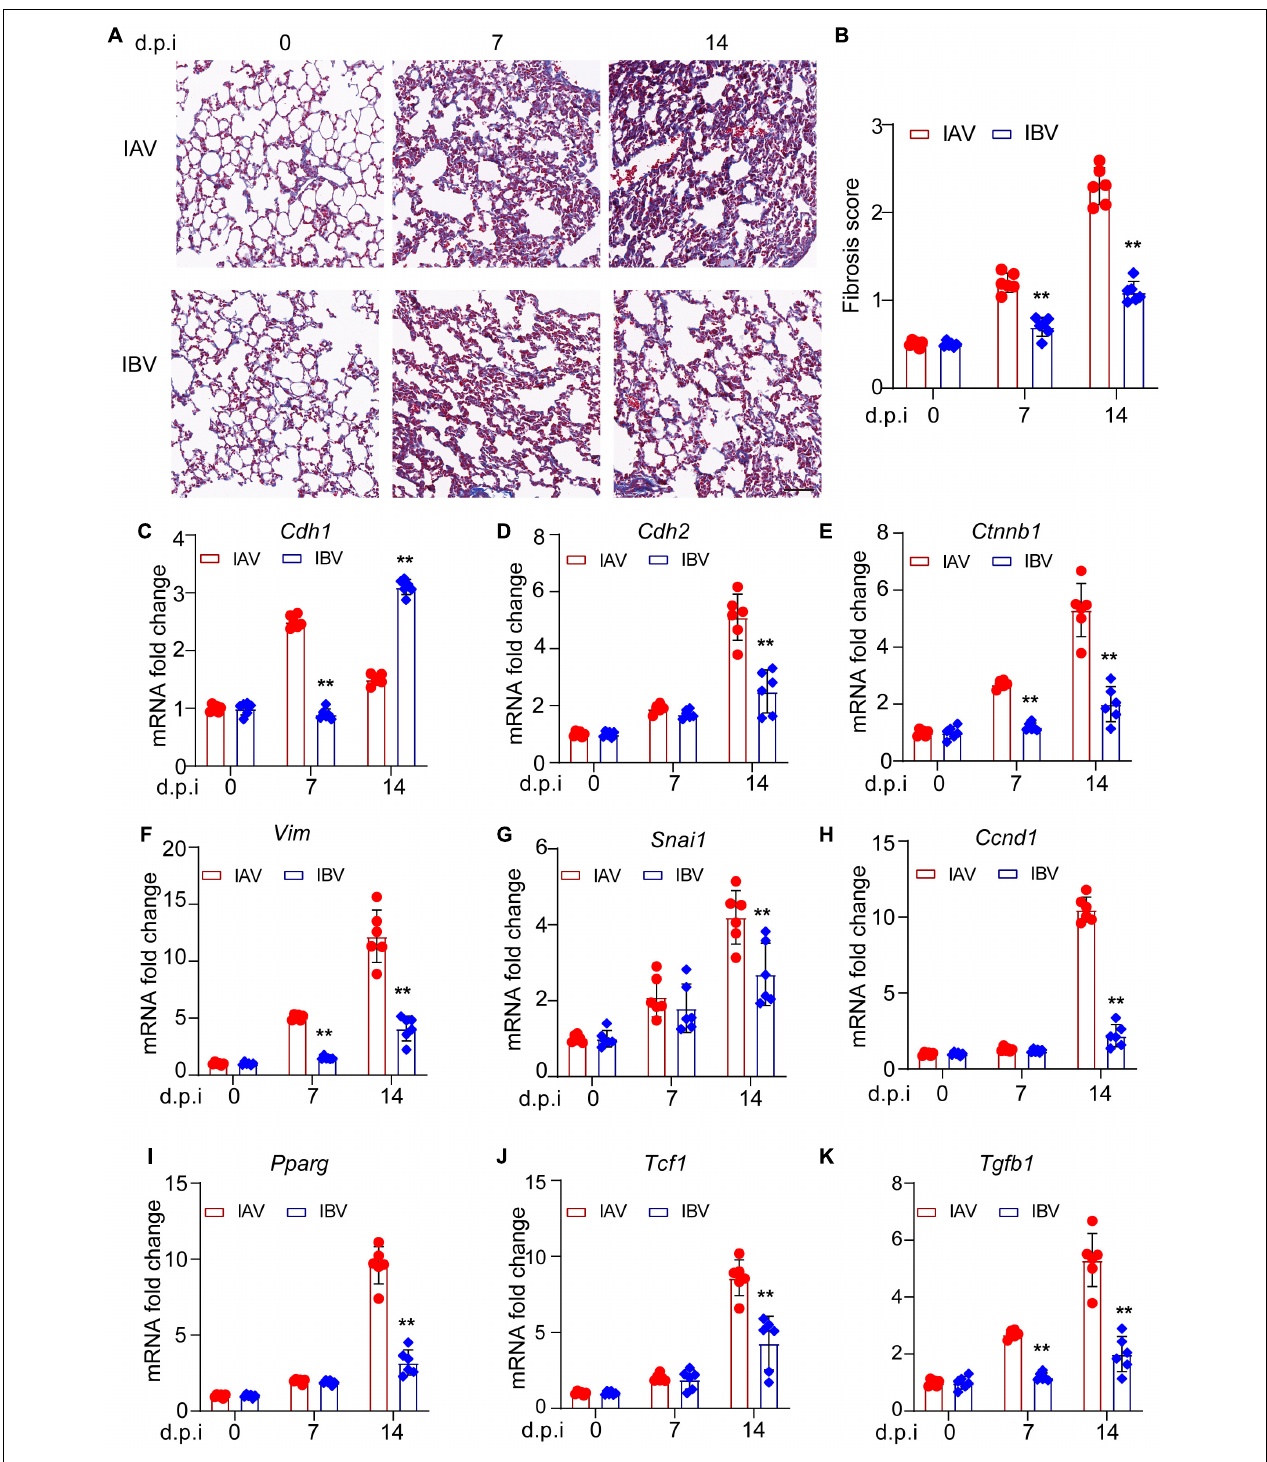
FIGURE 1 | Influenza A and B viruses induce pulmonary fibrosis and EMT-related gene expression in mice. Balb/c mice were intranasally treated with IAV (WSN) or IBV (Yamagata) (PFU = 3000) for the indicated time points. (A) Masson staining of lungs. Scale bar, 200 µ m. (B) Fibrosis scores. qPCR analysis of E-cadherin (C) , N-cadherin (D) , β -catenin (E) , vimentin (F) , snail (G) , cyclin D (H) , PPAR (I) , TCF-1 (J) , and TGF- β (K) in mouse lungs. Data are representative of three independent experiments ( n = 6). Data are presented as the mean ± SD for panels (B–K) . ** p < 0.01 (unpaired, two-tailed Student’s t -test).